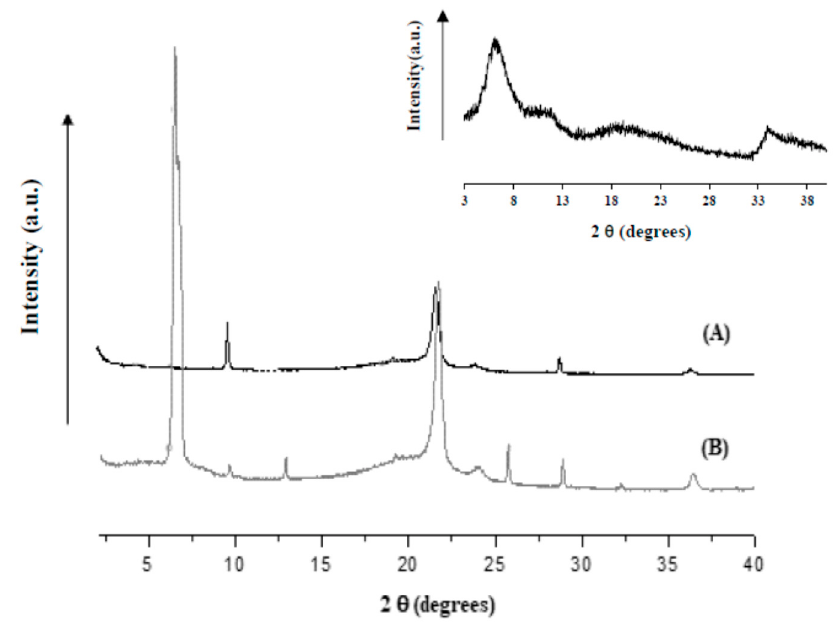
Figure 1. X-ray diffraction of unfilled polyethylene (PE) ( A ) and active film ( B ). Inset: Layered Double Hydroxides modified with salicylate molecule.